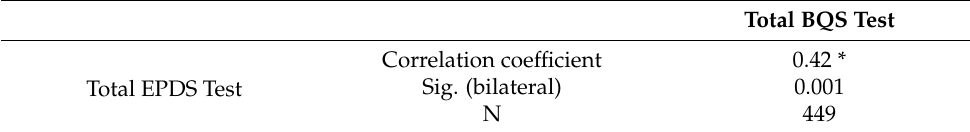
Table 3. Correlation between EPDS and BSQ